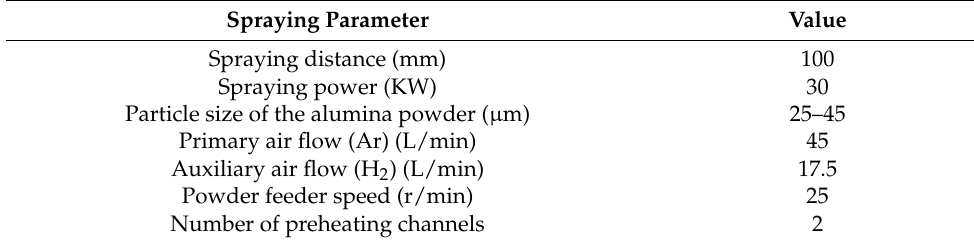
Table 2. APS process parameters.